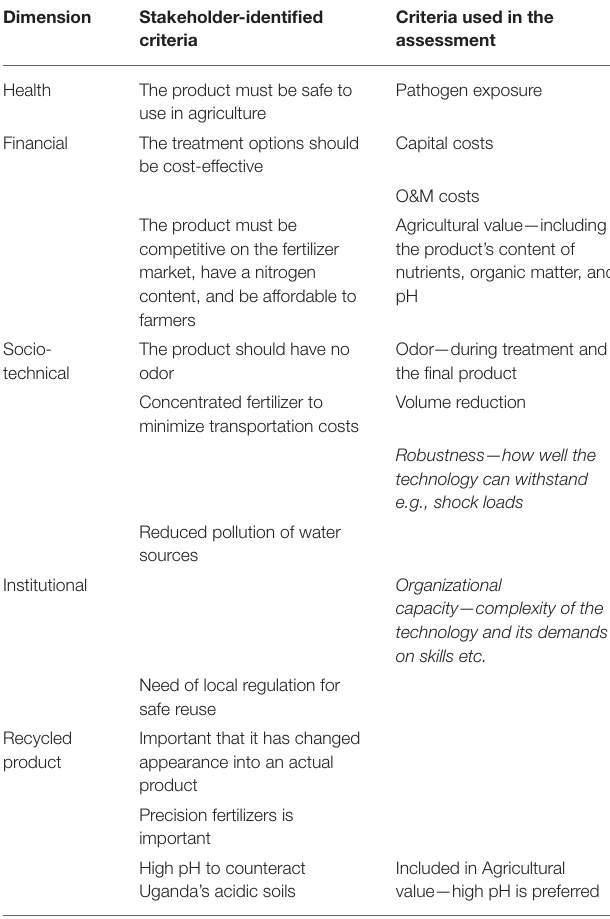
TABLE 3 | Stakeholder-identified criteria and criteria used in the sustainability assessment.